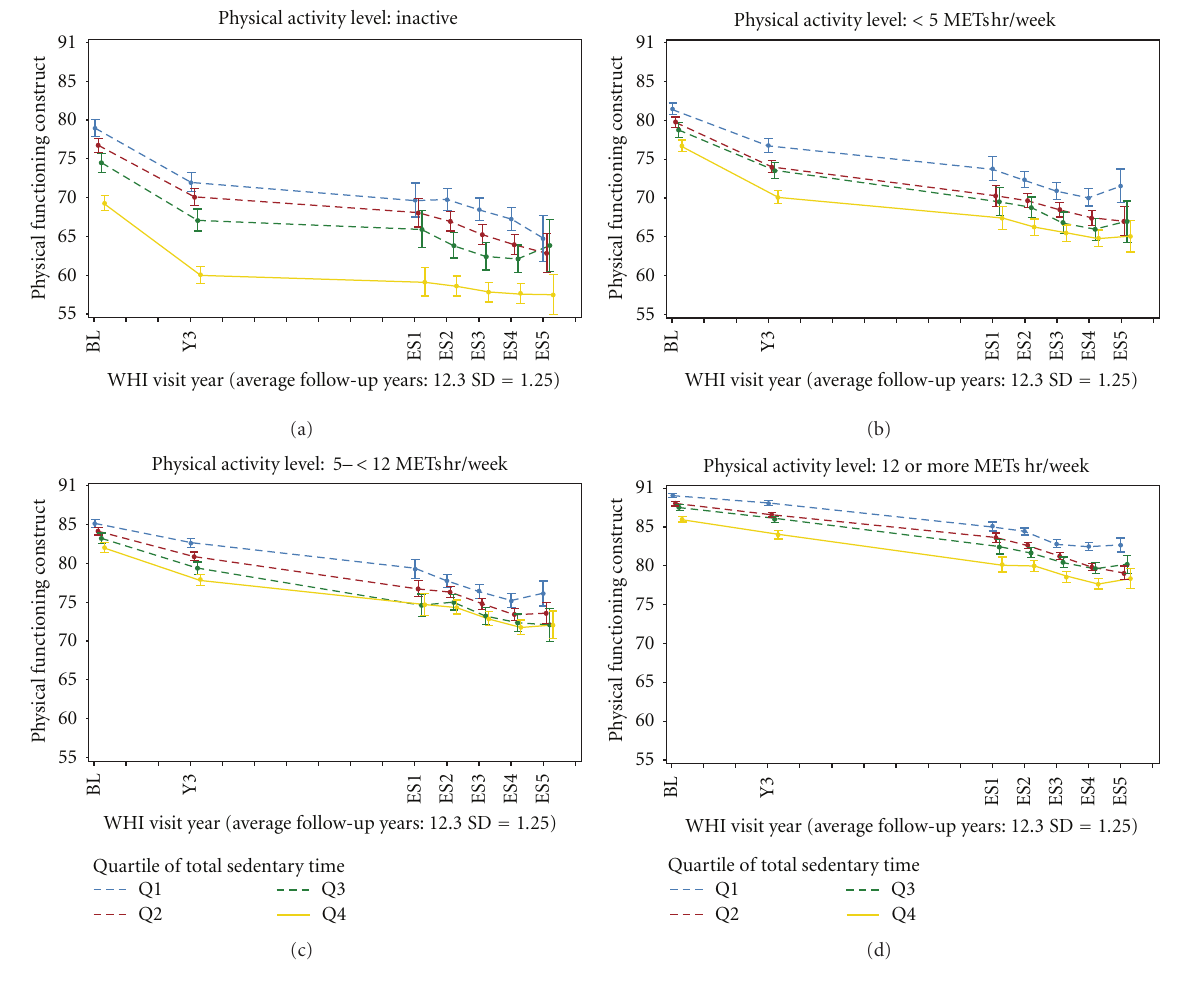
Figure 2: Physical function score over time by total sedentary time (year 3) and physical activity level, N =